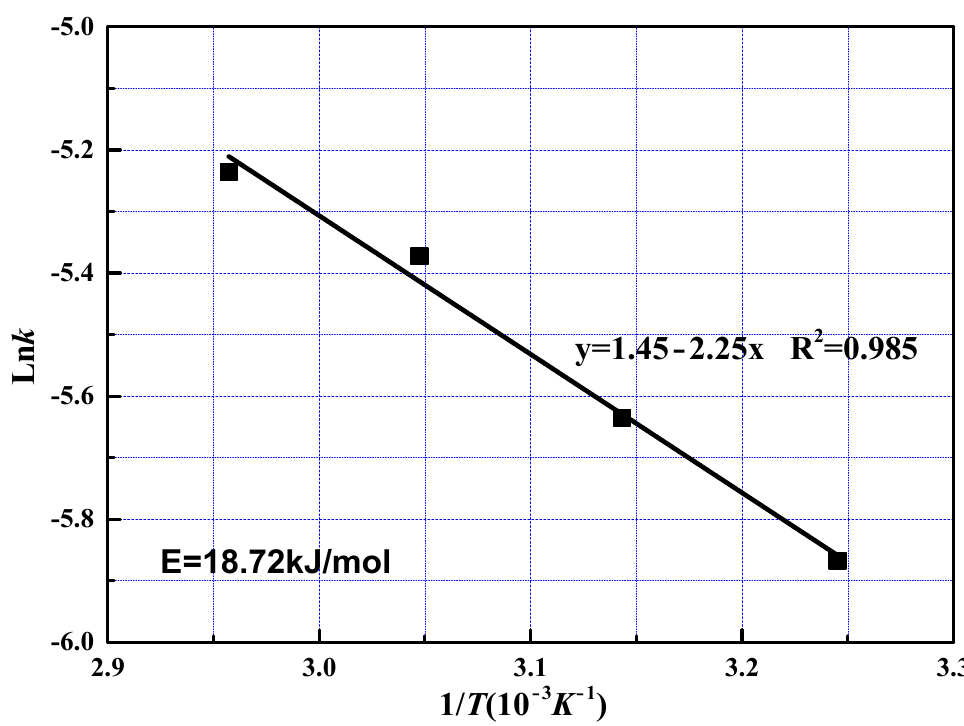
Figure 12. Arrhenius plot for leaching of REEs from phosphate ore at the slow reaction stage.